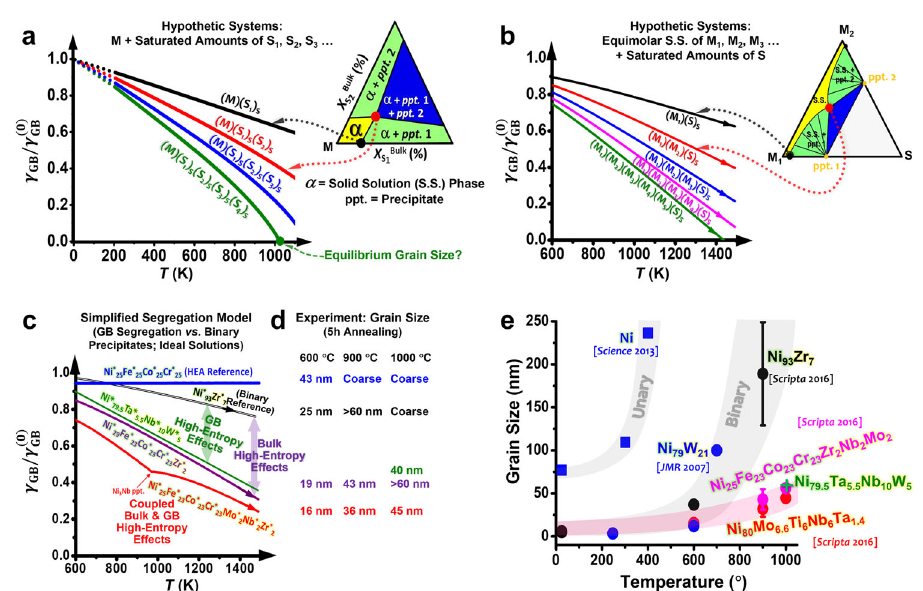
Fig. 2 Grain boundary (GB) and bulk high-entropy effects in high-entropy grain boundaries (HEGBs). a Computed normalized GB energy ( γ GB = γ ð 0 Þ GB ) vs. temperature ( T ) curves showing that a GB high-entropy effect can decrease d γ GB = dT along the solvus line in a hypothetic conventional multicomponent nanoalloy with one principal (M) and multiple segregating (S i ) elements. This GB high-entropy effect increases with increasing number of segregating elements. b Computed γ GB = γ ð 0 Þ GB vs. T curves along the bulk solvus curves, showing that γ GB can also be reduced via a bulk high-entropy effect that lower the bulk chemical potentials to suppress precipitation to promote GB adsorption for a hypothetic high-entropy nanoalloy of 1 – 5 principal (M i ) and one segregating element ( S ). In ( a and b ), subscript “ S ” indicates the bulk composition of the segregating element is kept saturated (on the solvus line) at each temperature. c Computed γ GB = γ ð 0 Þ GB ) vs. T curves for several “ Ni-like ” alloys, where the superscripts “ * ” are used note that the calculations were conducted by using a lattice model of ideal solutions with segregation enthalpies and bonding energies mimic the real alloys to capture useful trends. d Selected experimental results of measured grain sizes of nanoalloys annealed at three different temperatures for 5 h, which shows a correlation between reduced GB energies and grain sizes. e Experimentally measured grain size vs. annealing temperature curves for several nanoalloys with HEGBs along with Ni and Ni- based binary nanoalloys for comparison 9 . The numerical and experimental results are replotted or regenerated using the same procedures; the fi gure panels are reprinted or replotted after Zhou et al. 8, 9 , both with permission ©Elsevier